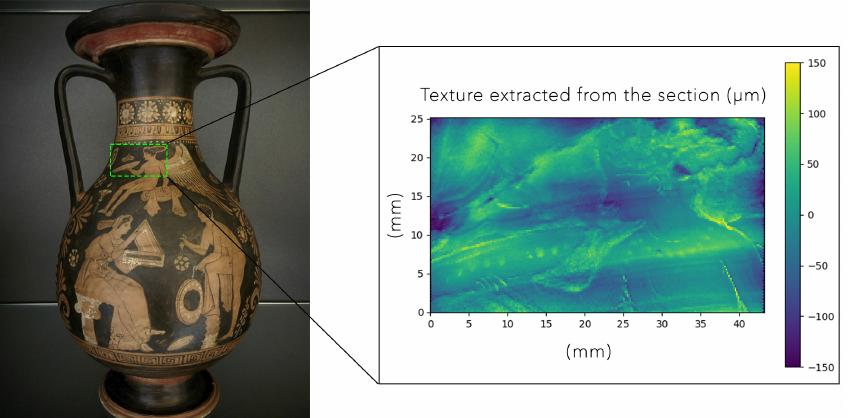
Figure 14. Red-figure pelike with the investigated ROI highlighted. The zoom shows the texture surface data, plotted as a height map, once the shape of the vase is removed.